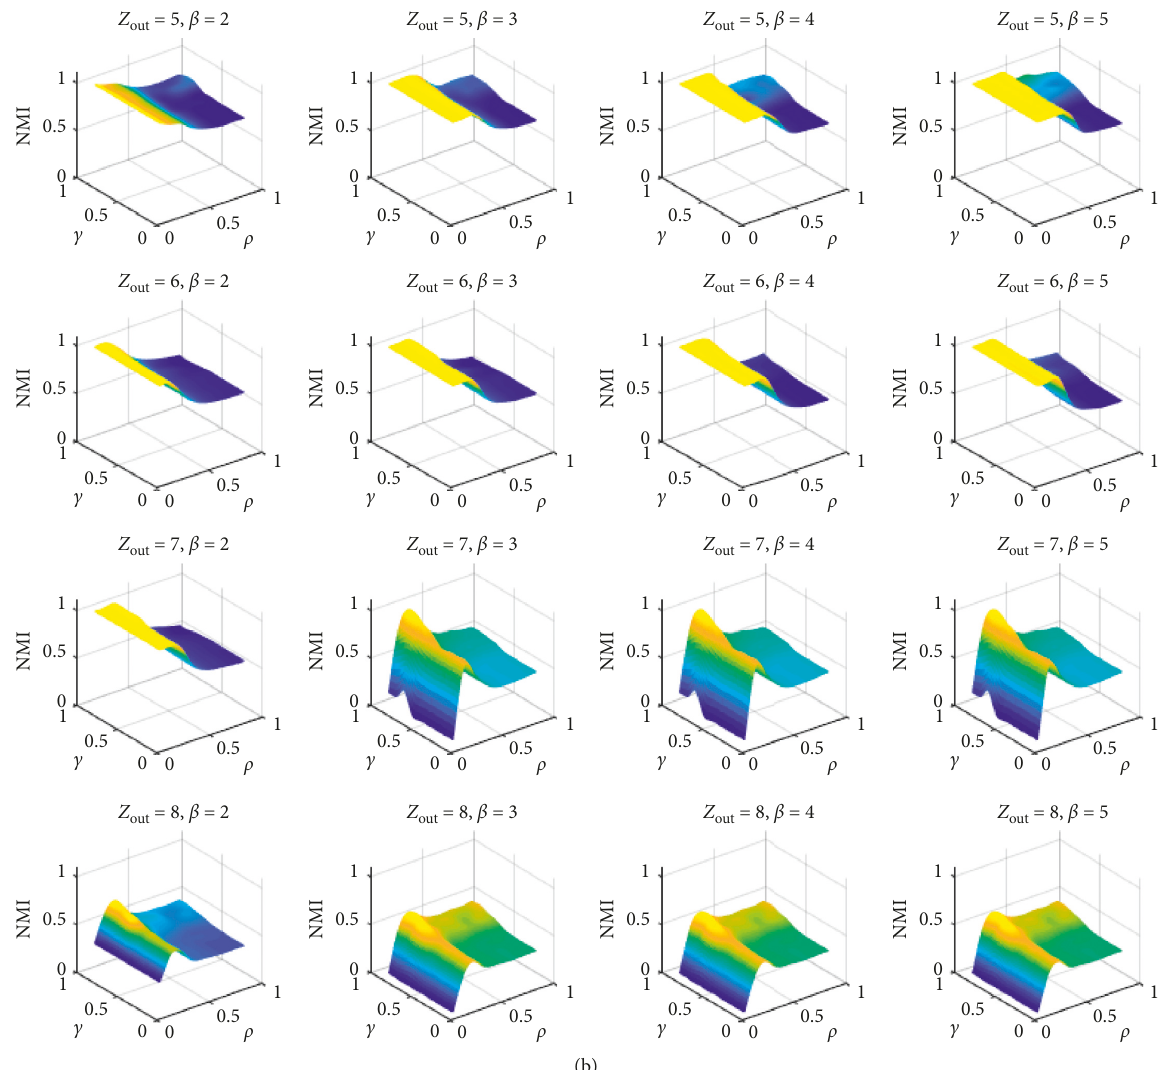
Figure 4: The sensitivity analysis of SAS algorithm detection results with parameters β , c , and ρ in GN benchmark. For each combination of parameters, 100 networks have been